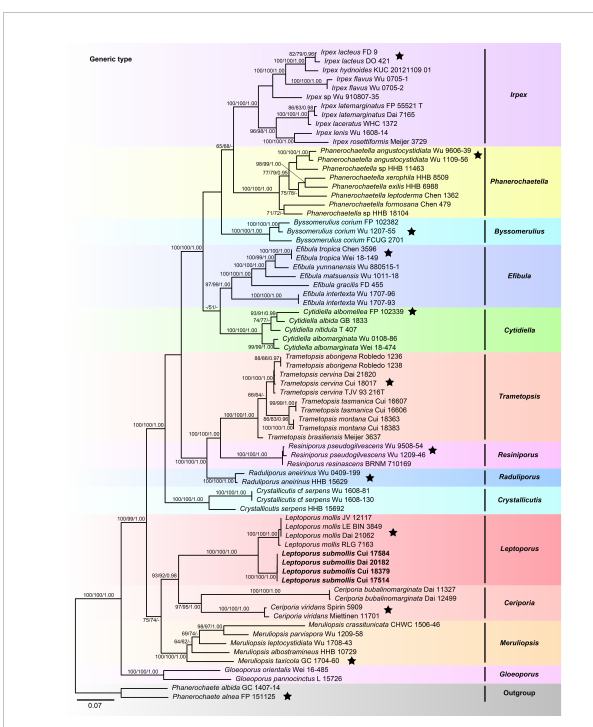
FIGURE 2 Maximum likelihood tree illustrating the phylogeny of Irpicaceae based on the combined sequence dataset of ITS+nLSU+ RPB1 + RPB2 + TEF1 . Branches are labeled with maximum likelihood bootstrap higher than 50%, parsimony bootstrap proportions higher than 50%, and Bayesian posterior probabilities more than 0.90, respectively. Bold names = New species.